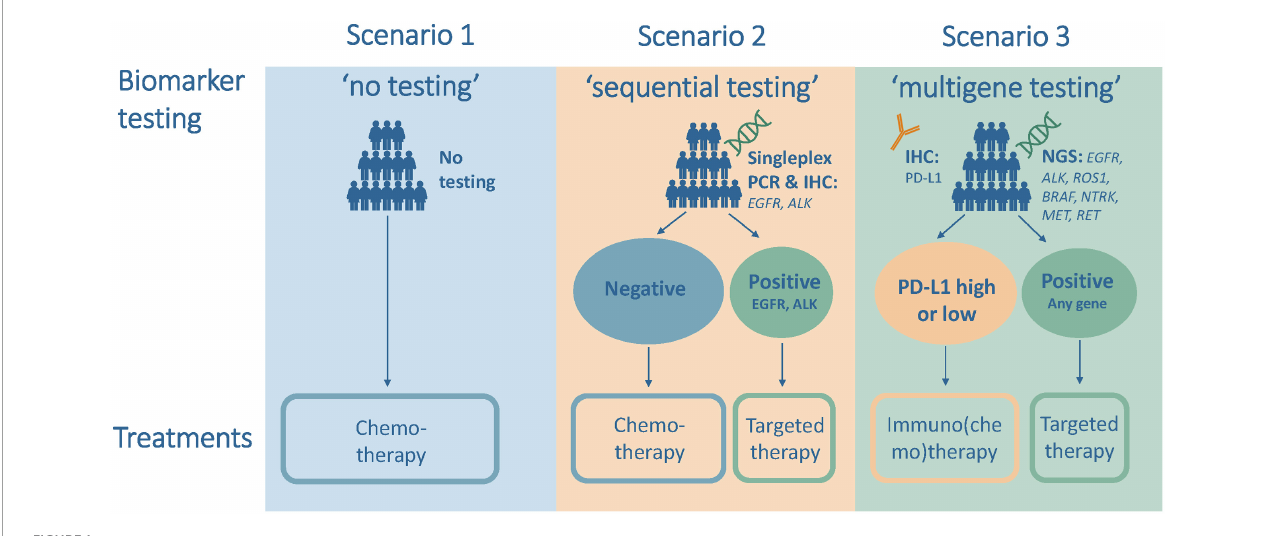
FIGURE1 Testing and treatment scenarios for the analysis of first-line treatment of advanced non-small cell lung cancer